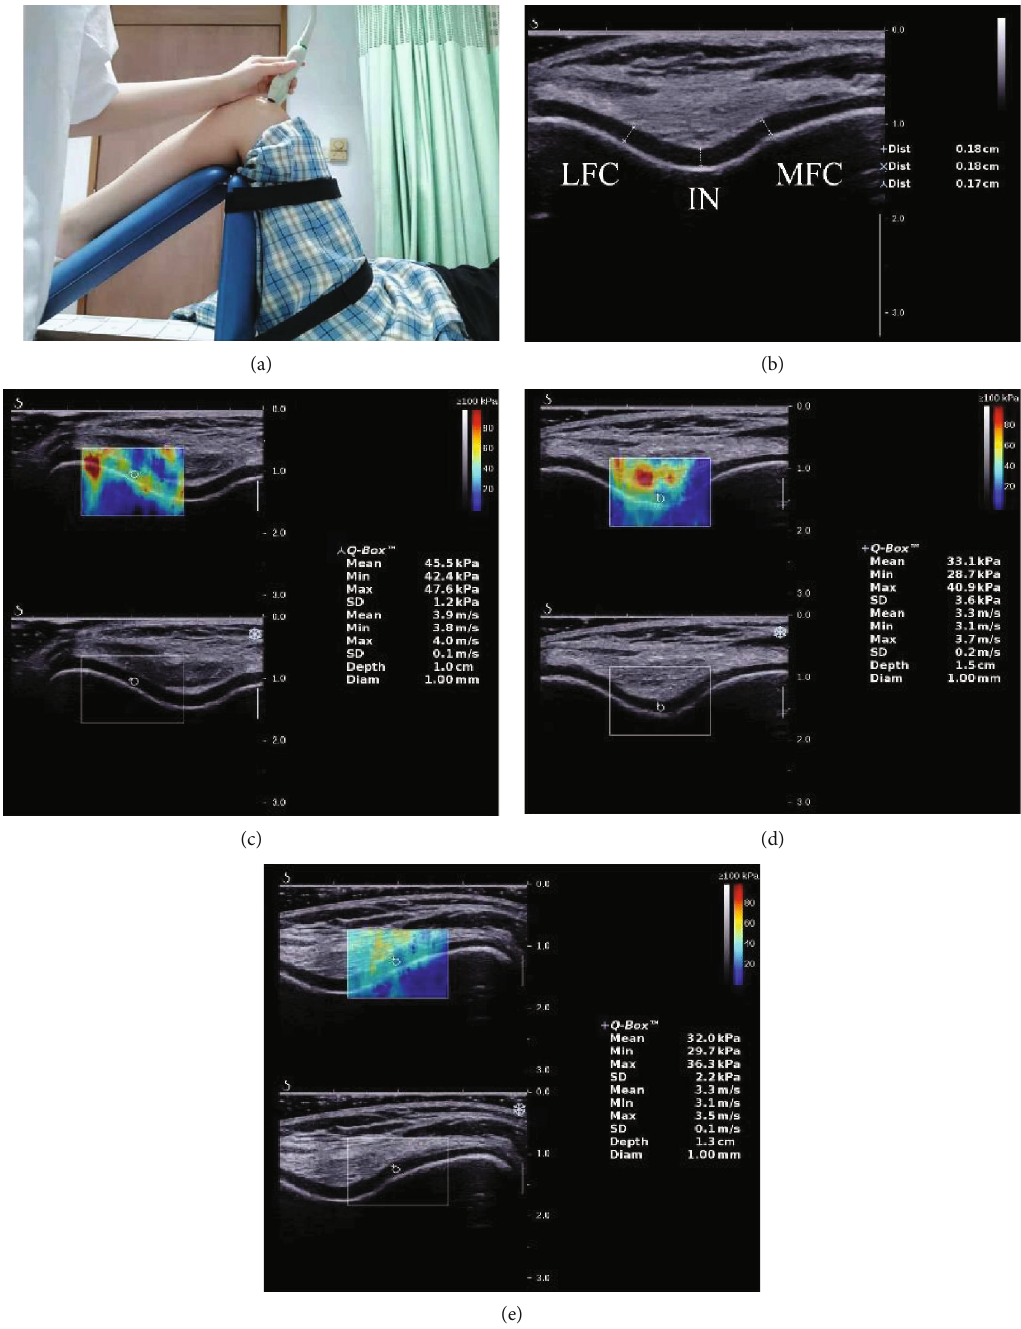
Figure 1: (a) The participant was supine, with one knee fi xed on a quadriceps femoris exercise board at 120 ° of fl exion. (b) B-mode maps for measuring the thickness of the distal FAC. (c – e): SWE maps for measuring the sti ff ness of the distal FAC. Upper images: color-coded box presentations of distal FAC elasticity were shown (the image color represents sti ff ness: blue represents soft while red represents sti ff ). Lower images: B-mode images of the distal FAC. The Q-Box ™ is shown on the right. IN: intercondylar notch; MFC: medial femoral condyle; LFC: lateral femoral